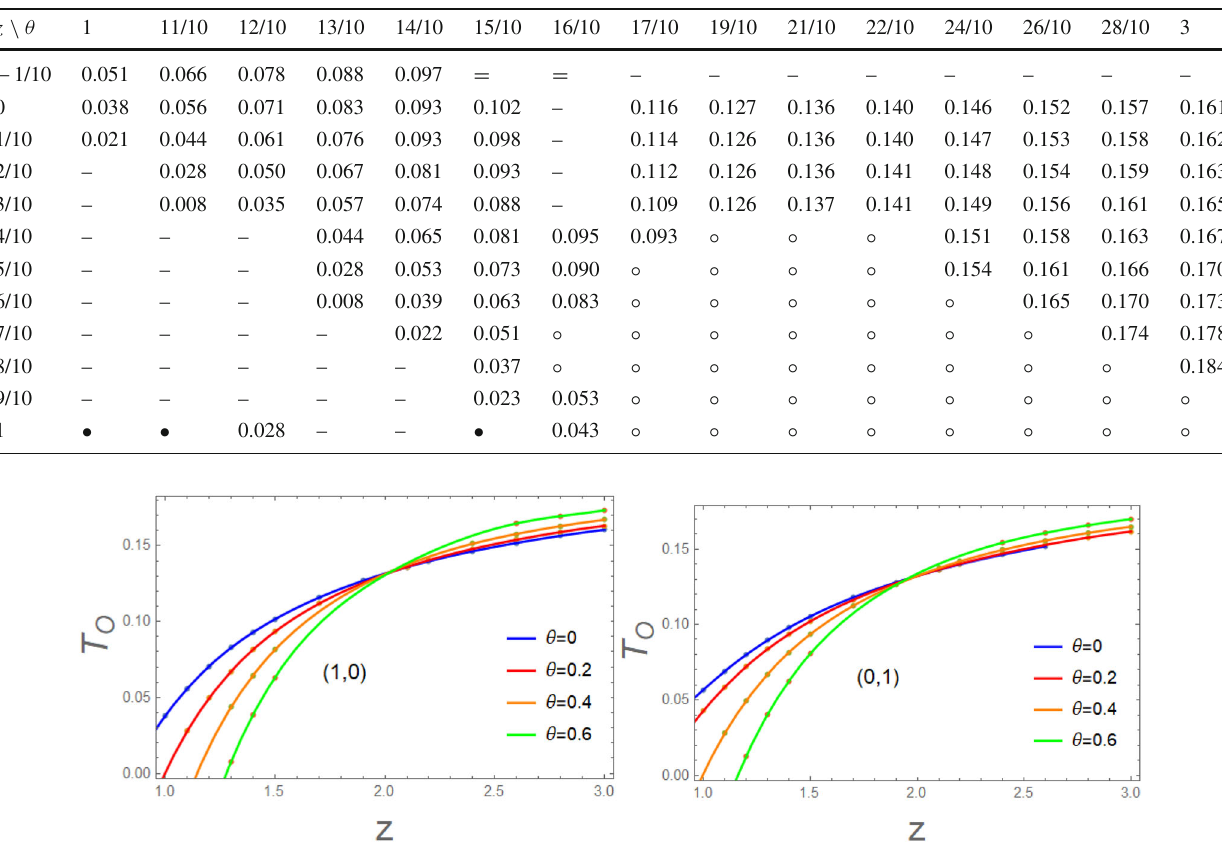
Table 1 Optimal temperature T O and SC dome with different z and θ : “–” denotes negative T O . “ • ” denotes the monotonously decreasing T c . “ ◦ ” denotes the monotonously increasing T